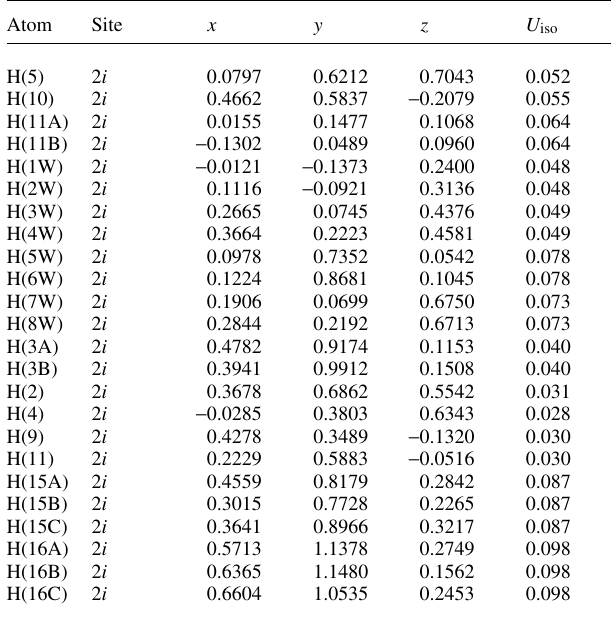
Table 2. Atomic coordinates and displacement parameters (in Å 2 ) .